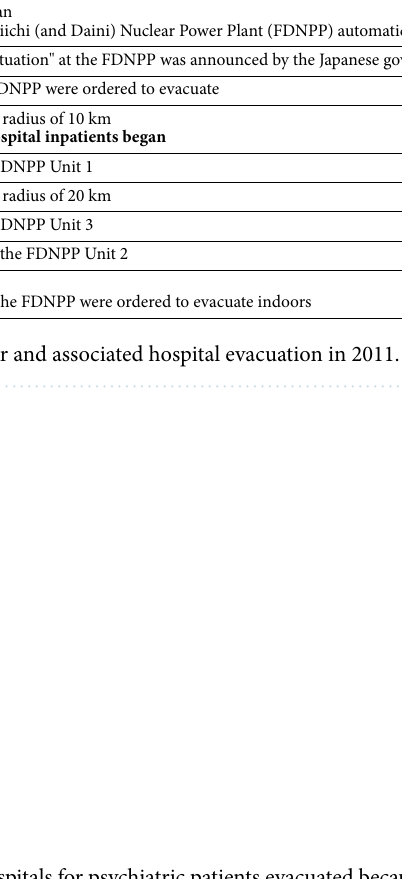
Figure 1. A map of prefectures where destination hospitals for psychiatric patients evacuated because of the FDNPP accident are located. Destinations are shown as circles. The triangle shows Fukushima prefecture, which includes the hospitals where evacuated psychiatric inpatients had been hospitalized before the GEJE and FDNPP. The cross shows the FDNPP. Microsoft PowerPoint (https:// www. micro soft. com/ en- us/ micro soft- 365/ power point) version 2016 was used to create the